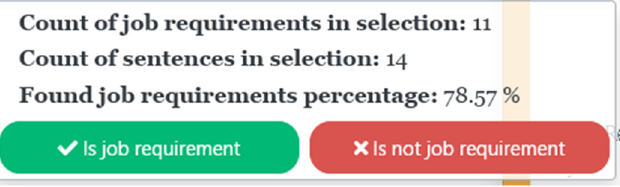
Figure 9. Panel to determine if a sentence contains job requirements or not. For the feedback purposes, there is a database table created which contains all user interventions into the training dataset. Once a button is pressed, the table is searched through. If it contains a record with a currently highlighted sentence, the counter of positively or negatively marked sentences increases by 1. This can filter out the effects of a human factor on the whole model. If one sentence is, for example, marked three times positive (as containing job requirements) and the user makes a mistake and marks it once negatively, it does not affect the training dataset. Part of the database table containing user feedback records is depicted in Table 1. Table 1. Part of the database table containing user feedback records.